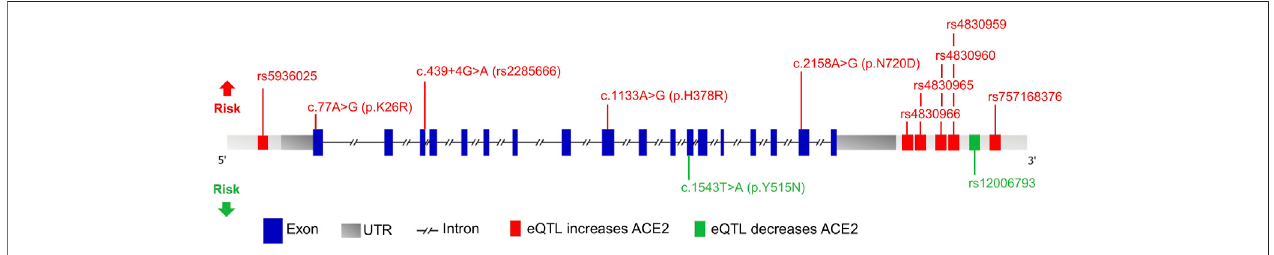
FIGURE 5 | Schematic representation of the ACE2 gene with variants affecting risk. Genomic structure is based on the Ensembl canonical transcript (ENST00000252519.8), which has 18 exons, a transcript length of 3,339 bps, and a translation length of 805 residues. Exons are shown as blue boxes, the 5 ′ and 3 ′ UTRsareshownasgreyboxes,andthehorizontalblackdashedlinerepresentstheintrons.TheeQTLsthatincreaseanddecreaseACE2expressionlevelsaredepicted asgreenandredboxes,respectively.OnlyeQTLswithaCohen ’ sdeffectsize > 0.2areshown.MissenseandsplicingvariantsareshownwiththeirCDSandprotein position. The locations of the variants associated with increased and decreased COVID-19 susceptibility are shown above and below the gene,